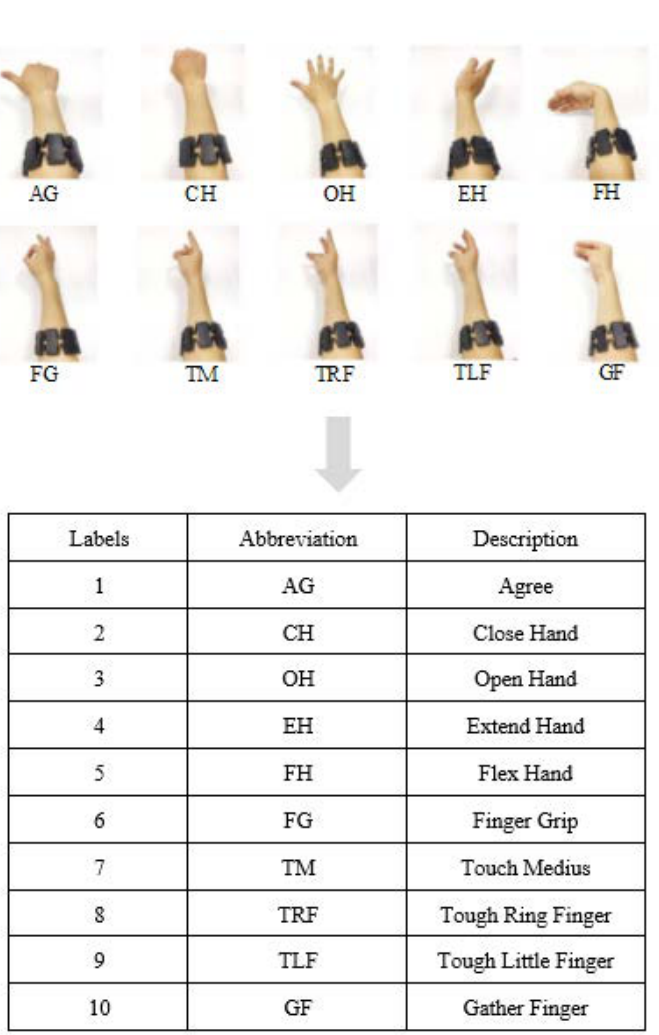
. Figure 3. Movement categories and definitions. The data segment is necessary to study every single gesture, and a window is added to get the rough range. After that, data smoothing is done to obtain the absolute maximum value, we choose 20% of the maximum as the boundaries for both left and right. The wave of channel three’s 10 single gestures is shown in Figure 4.